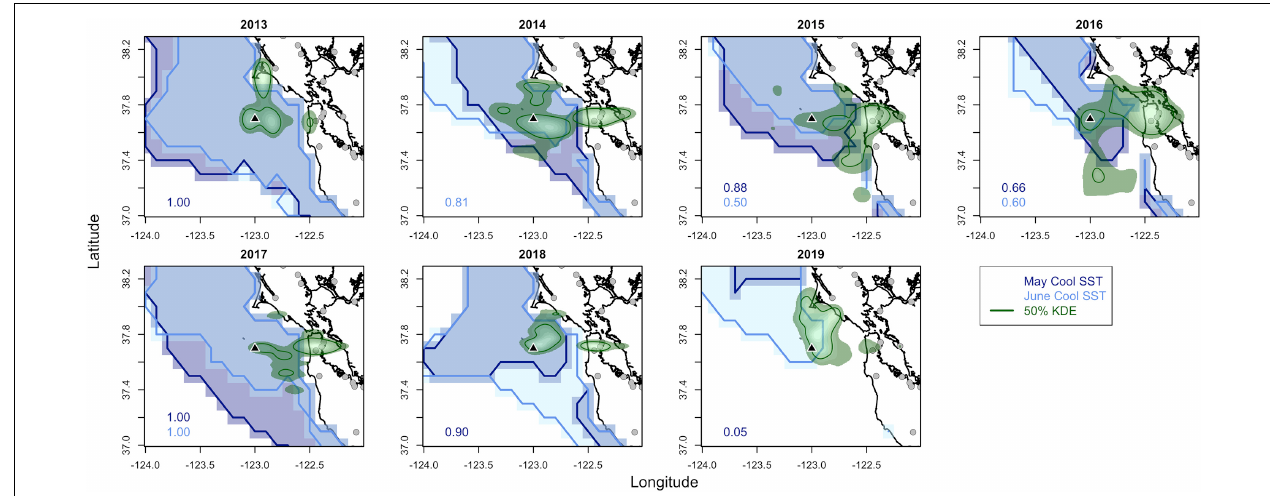
FIGURE 4 | Western gull kernel density estimates (KDE, green) for foraging locations for each year with the outer area being the 75% KDE and the inner 50% KDE line representing the core foraging area. The area with cool sea surface temperature (SST) in May (SST below 11.5 ◦ C) and June (SST below 12 ◦ C) is shown with the numbers indicating the range overlap between gull foraging locations and cool SST for each month. Southeast Farallon Island is the black triangle and landfills/recycling centers are the gray circles.